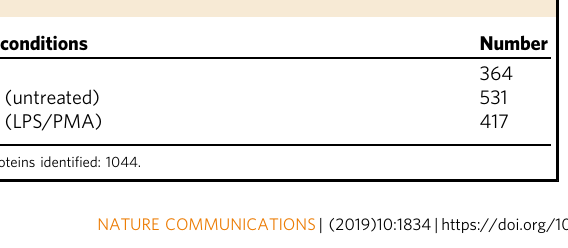
Table 1 Total number of non-redundant proteins identi fi ed per cell line and